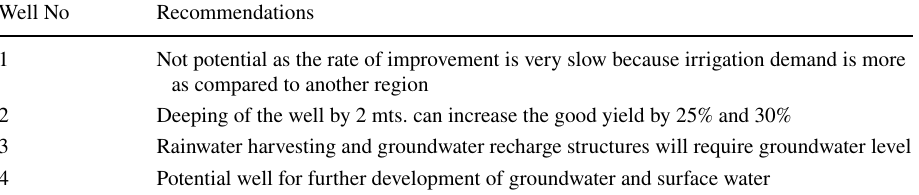
Table 3 Recommendation based on the groundwater flow